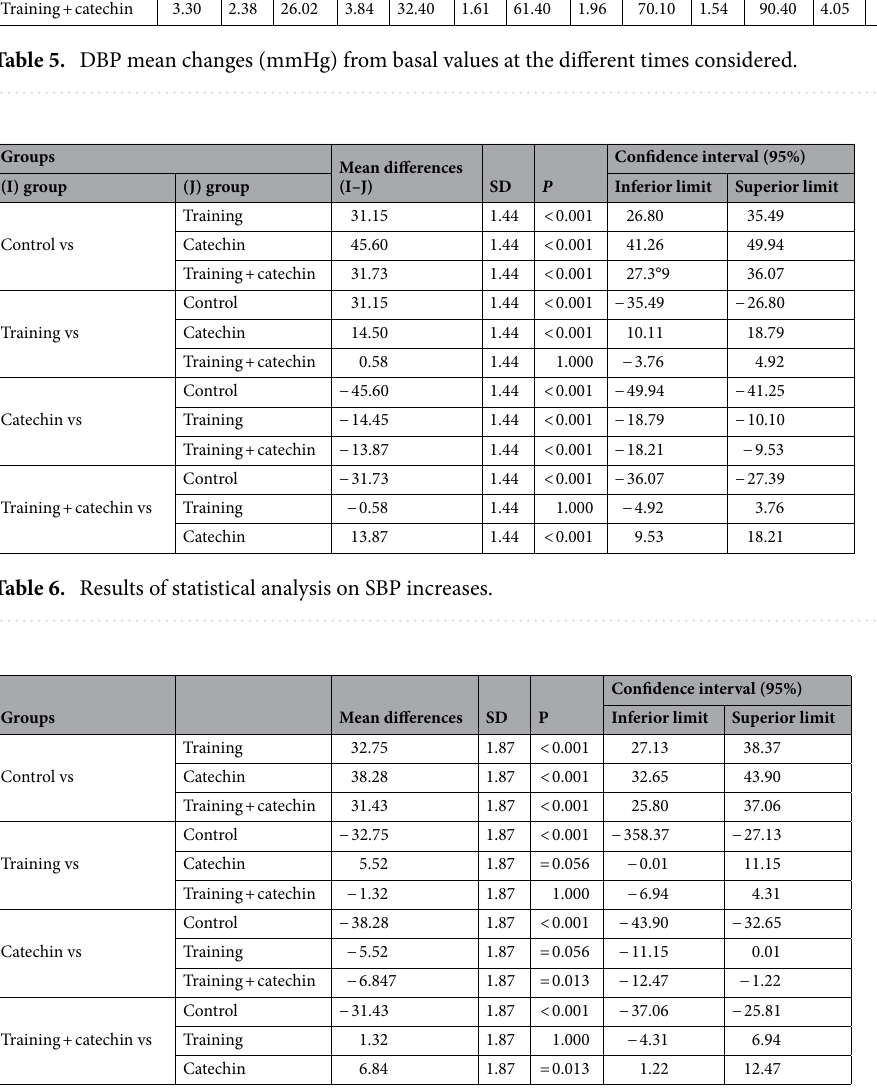
Table 7. Results of statistical analysis on DBP